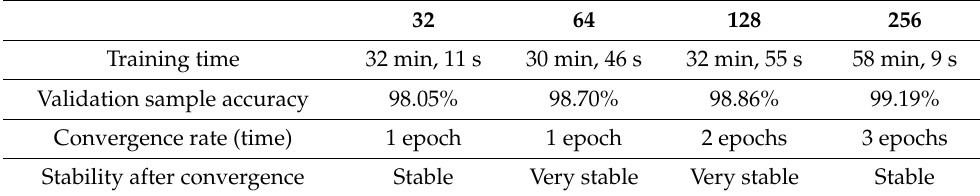
Table 2. SqueezeNet training effects of different batch sizes.